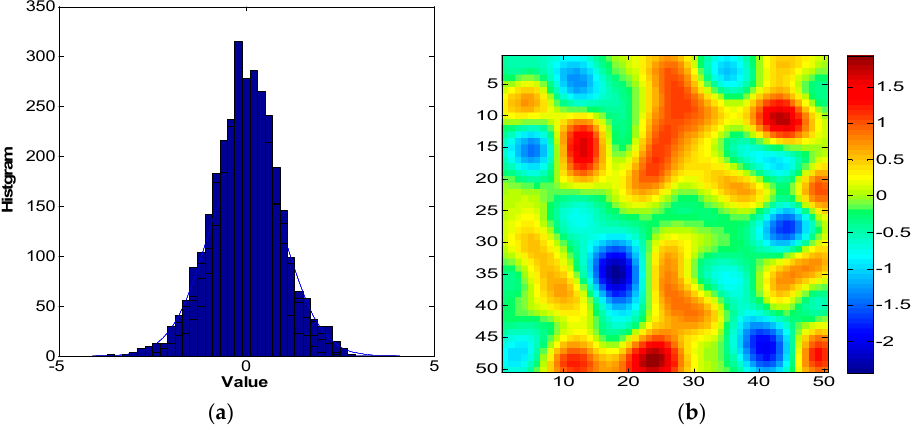
Figure 3. The random field generated by KL expansion with 100 leading terms. ( a ) marginal distribution of fields; ( b ) the contour of the field.